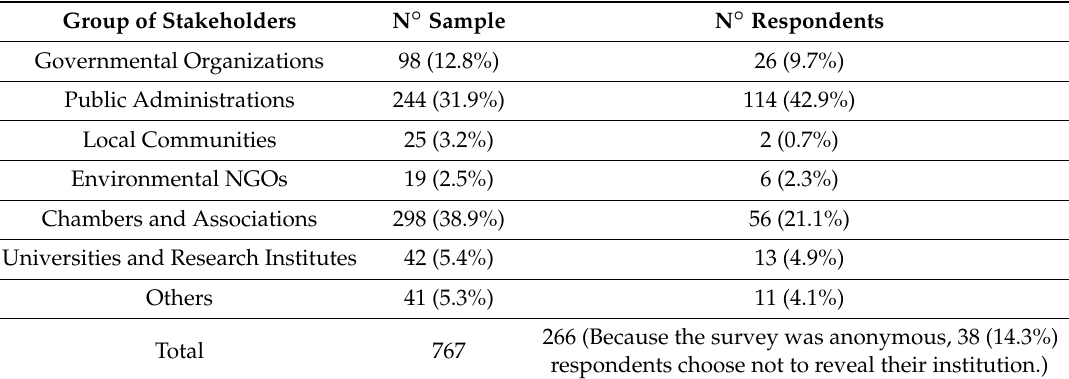
Table 3. Stakeholders Involved in the